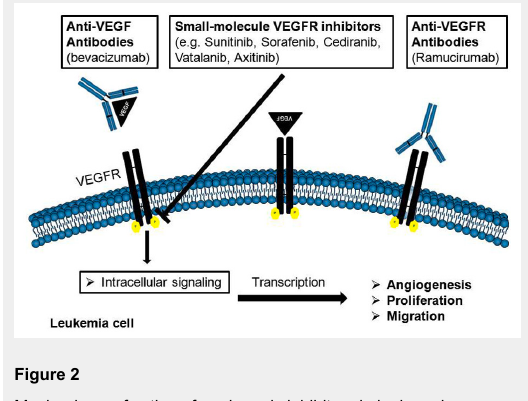
Mechanisms of action of angiogenic inhibitors in leukaemia. VEGF = vascular endothelial growth factor VEGFR = vascular endothelial growth factor